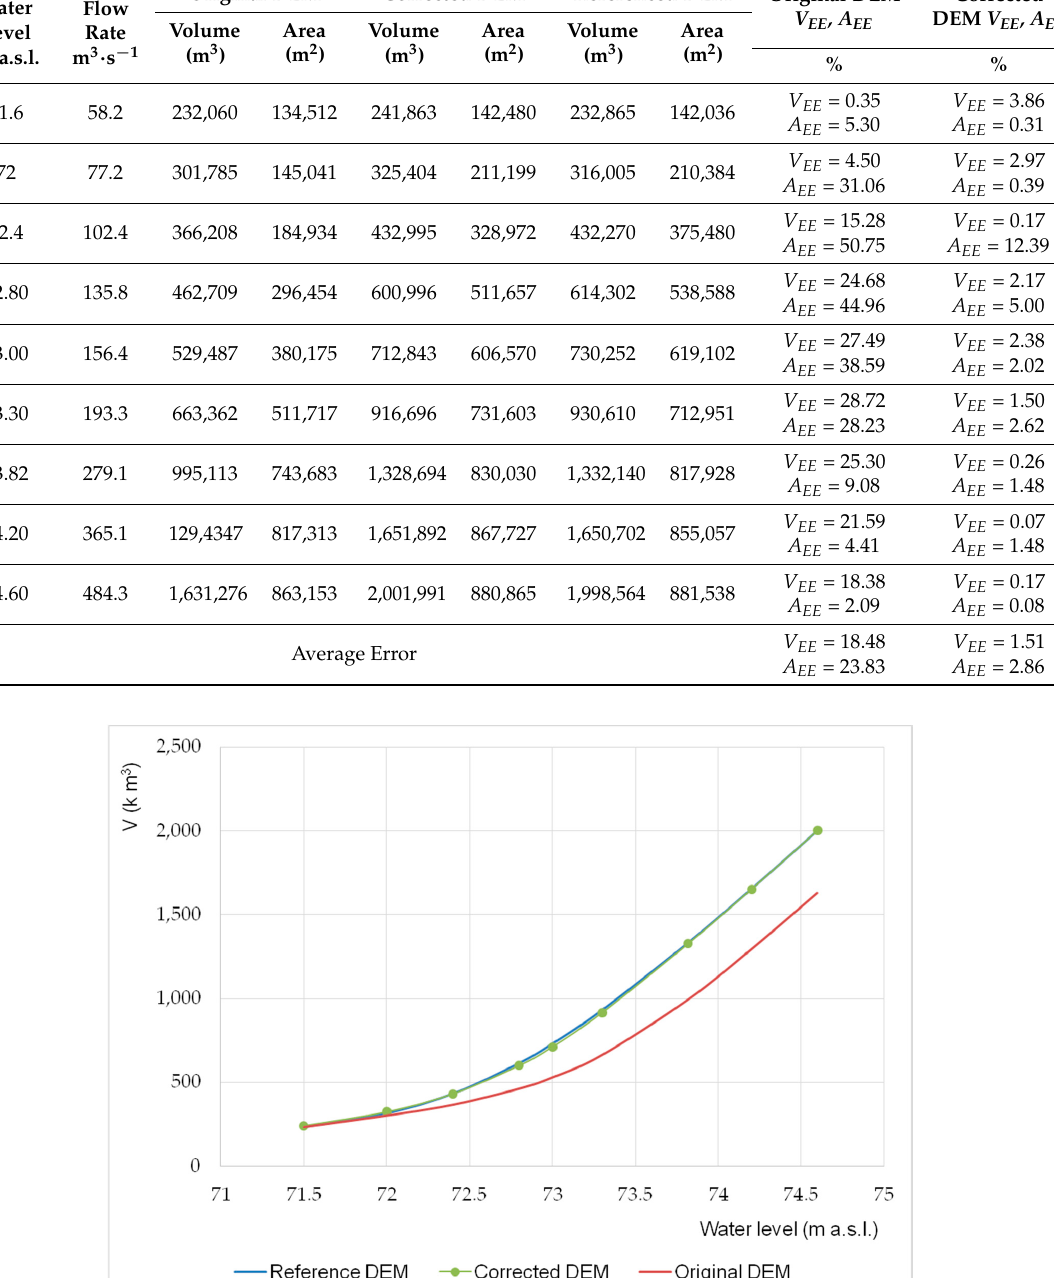
Table 2. Comparison of the results obtained from 2D model based on various DEMs.